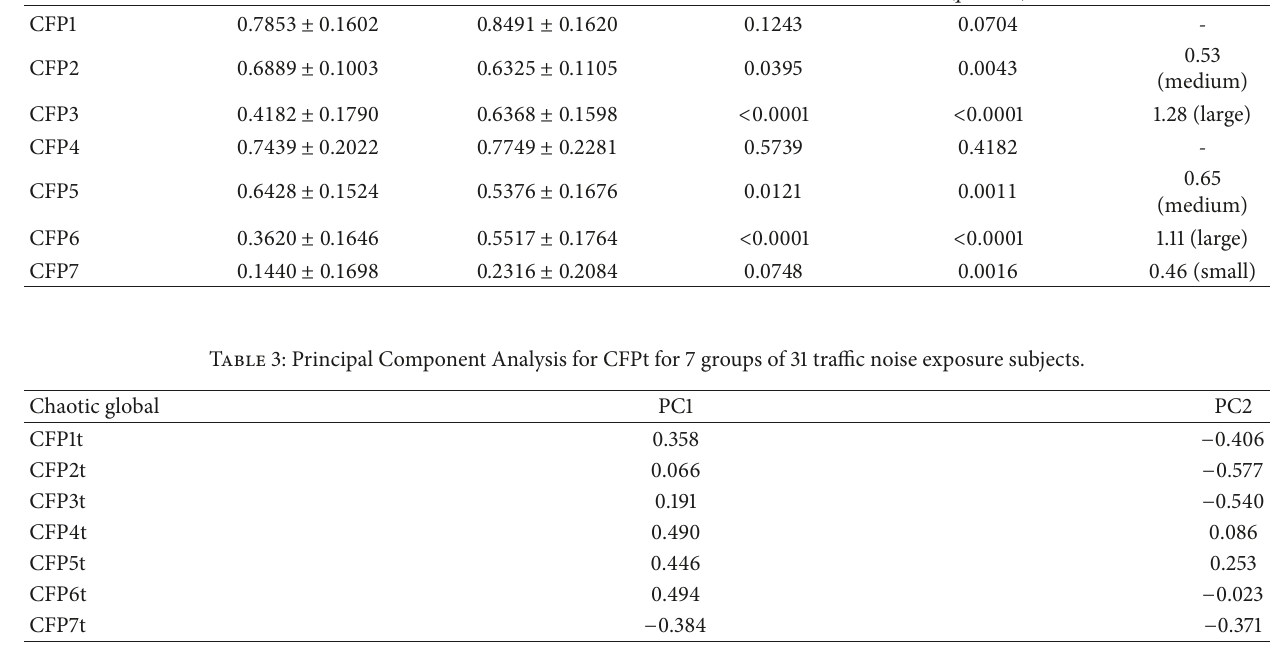
Table 2: Mean values and standard deviation for the chaotic forward parameters (CFP) for the normal and traffic noise exposure subjects. Chaotic global